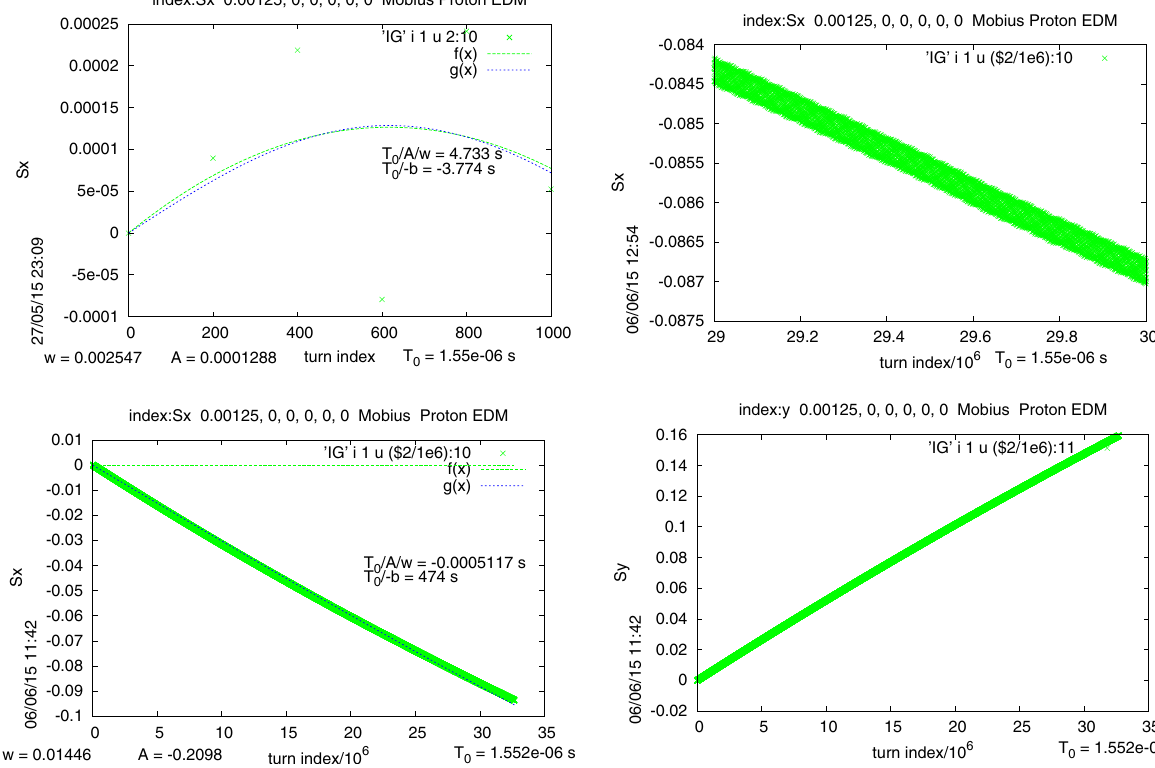
FIG. 7. Evolution of spin components for 33 million turns. Because S z ¼ 1 initially, both S x and S y vanish at x ¼ 0 , where x is turn number. The upper left figure shows S x for the first 1000 turns, as fit by a sinusoid A sin ð wx Þ where the horizontal axis variable x is, in this case, turn number. The upper right figure shows S x for one million turns starting at x ¼ 29 million. The lower left and lower right figures show the evolution of S x and S y for the full 33 million turn run. Though these motions are oscillatory the oscillation amplitudes are less than the linewidth. The lattice file is E_pEDM-rtr1-Mobius.RF.sxf